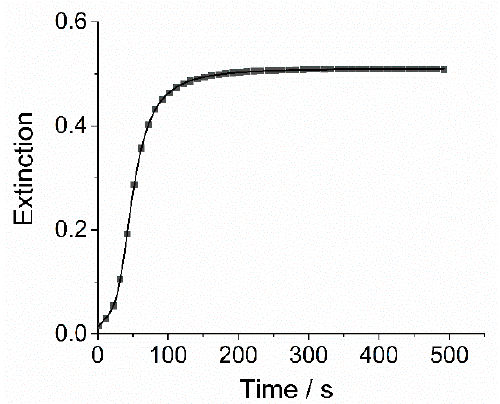
Figure 2. Typical kinetic profile of extinction at 491 nm vs time for the aggregation of TPPS 4 catalyzed by CoT 4 . The black line is the best fit of the experimental data to Equation (1) (Experimental conditions: [TPPS 4 ] = 3 μ M; [CoT 4 ] = 1.5 μ M; [HCl] = 0.00158 M, T = 298 K) .